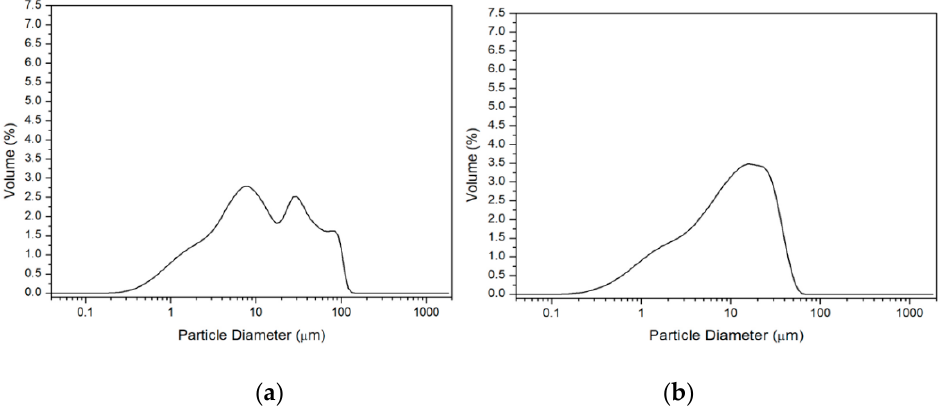
Figure 2. Particle size distribution of fillers from waste materials: ( a ) Fly ash and ( b ) blast furnace slag.